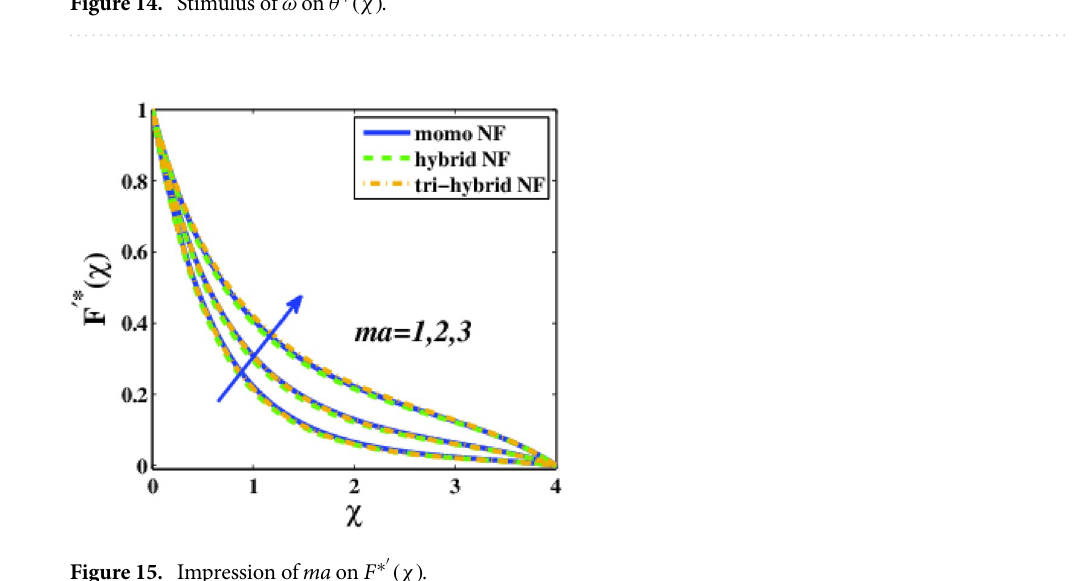
Figure 15. Impression of ma on F ∗ ′ (χ) .